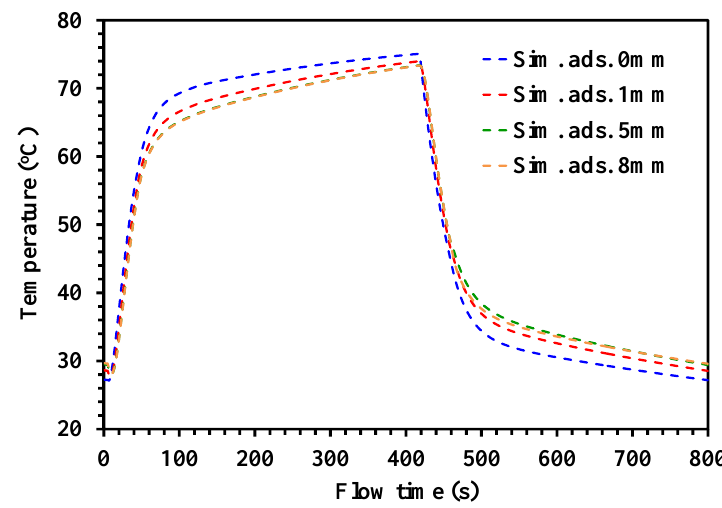
Figure 7. Simulated temperature profiles at different adsorbent thickness.